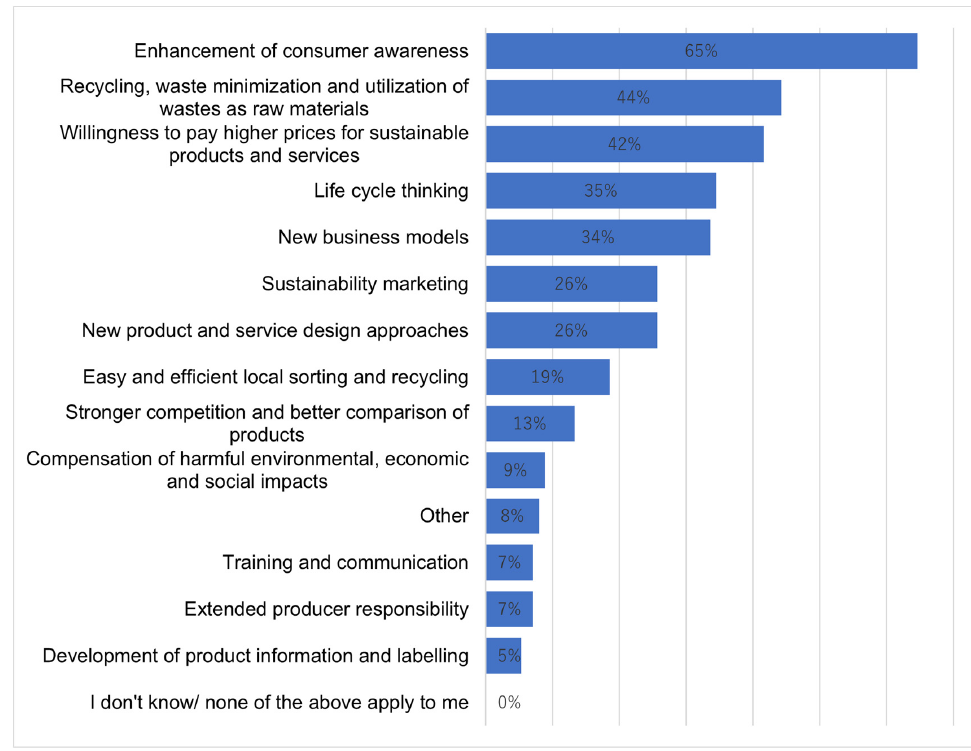
Figure 8. Best approaches to promote sustainable consumption.